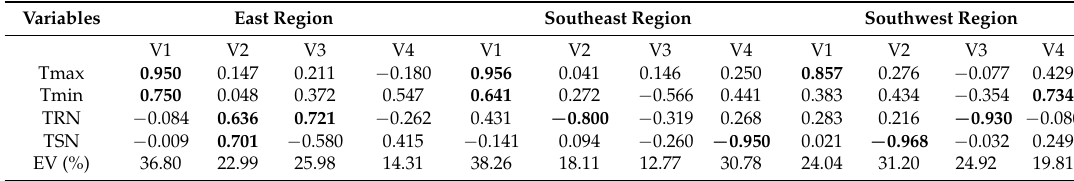
Table 3. Structure coefficients derived using seasonal climate indices (DJFM) in three hydroclimatic regions. Climatic variables.